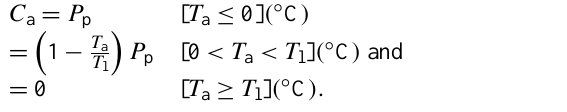
Figure 4. Flowchart of calculation of precipitation at average ele- vation of